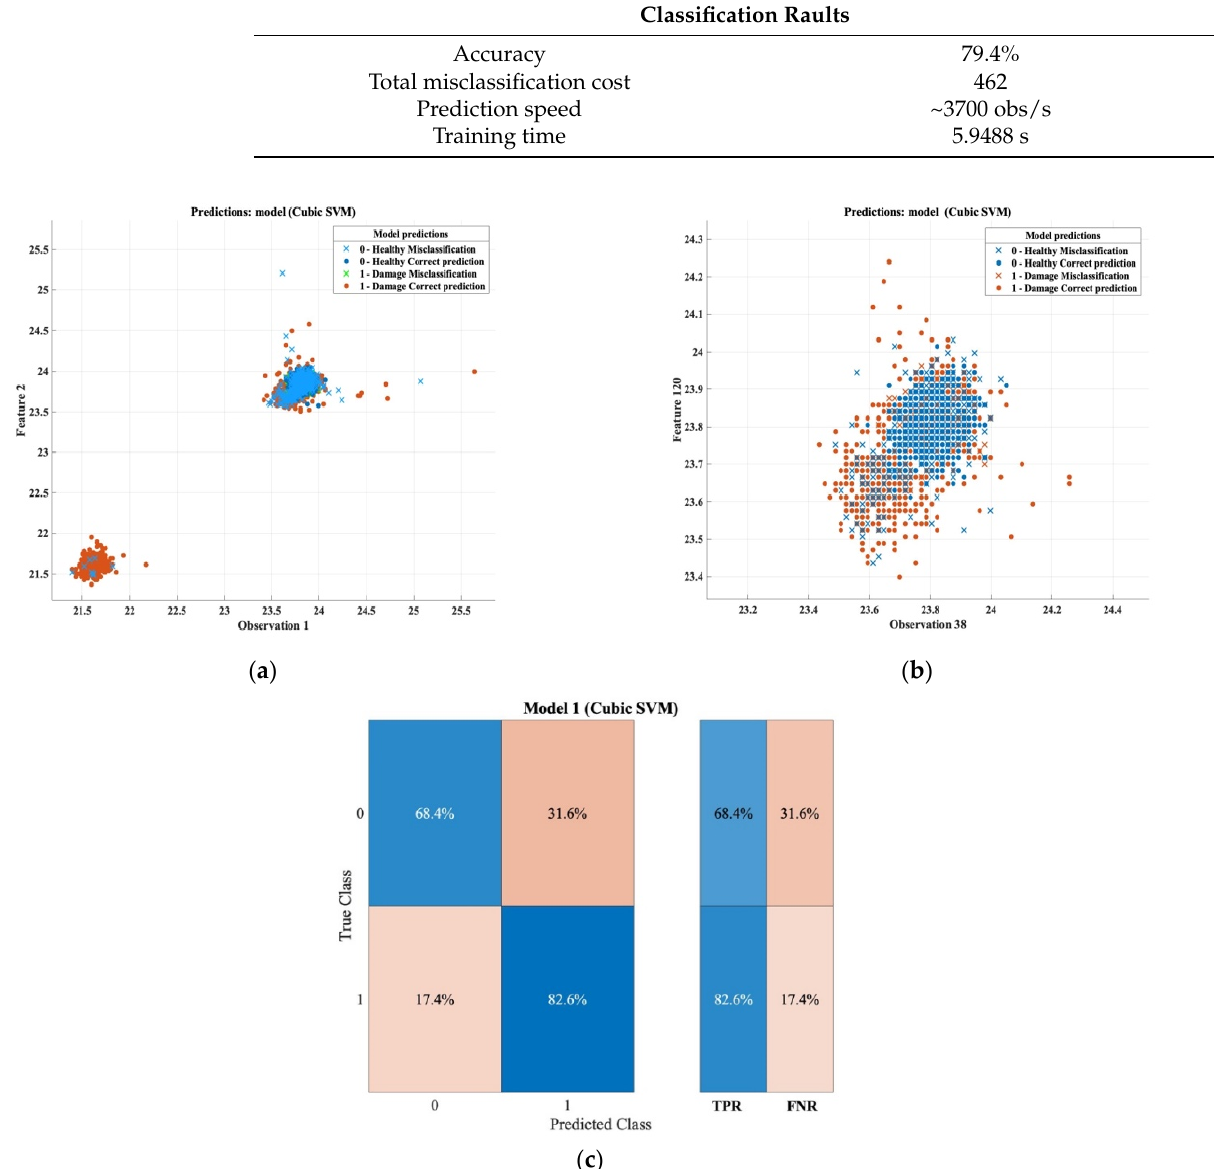
Figure 15. Classification results and confusion matrix for thin samples based on transmission mode. ( a ) Features patterns of classification results of the cubic SVM model (observation 1 vs. feature 2). ( b ) Features patterns of classification results of the cubic SVM model (observation 38 vs. feature 120). ( c ) Confusion